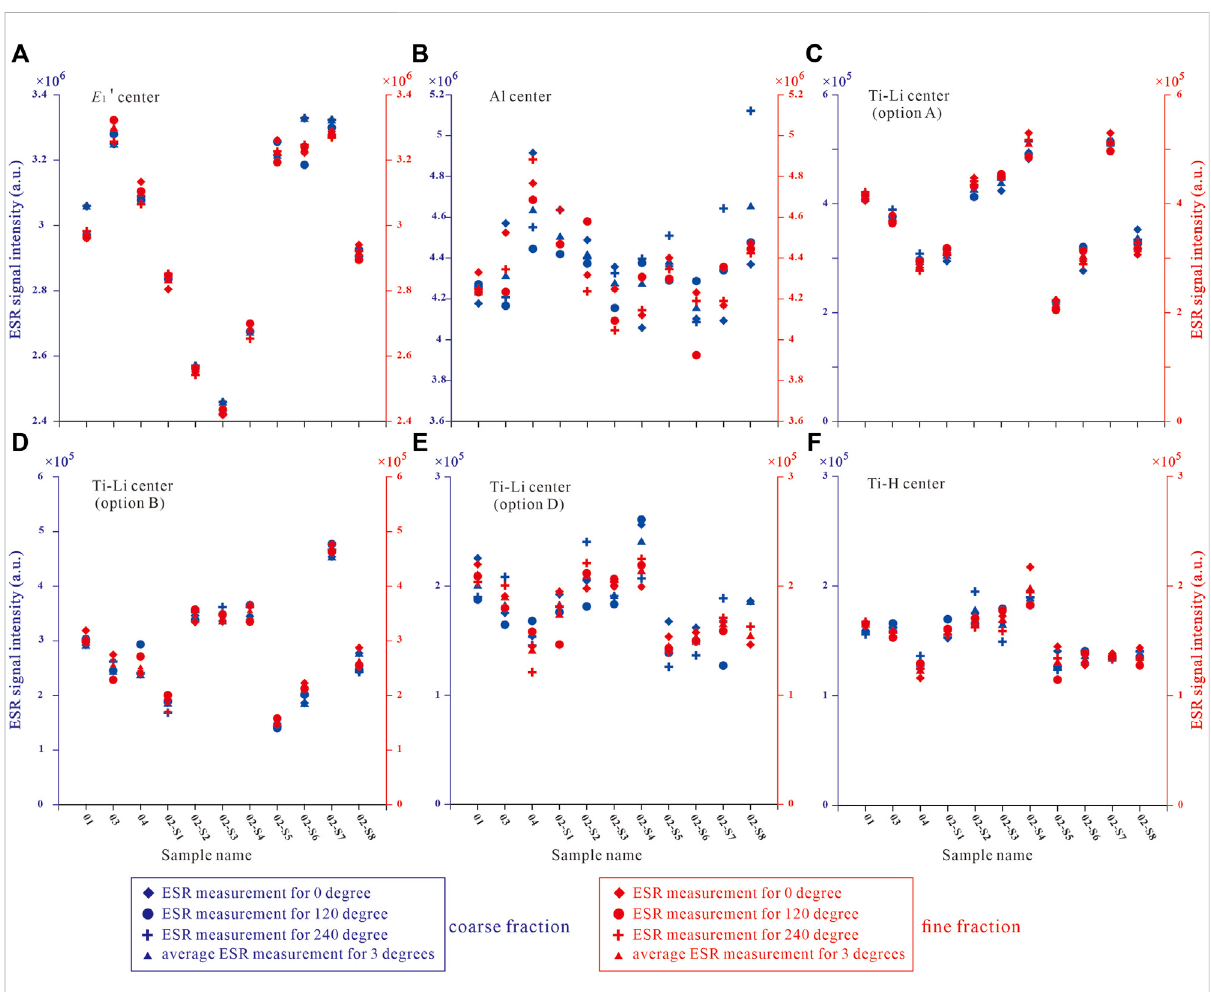
FIGURE 8 Residual signal intensities of multiple ESR centers incoarse and fi nefractions ofquartz in diluvia of theBaige dammed lake. The coarse and fi ne quartzresidualsignalintensitiesofE1 ’ centerfor (A) ,Alcenterfor (B) ,Ti-Licenter(optionA)for (C) ,Ti-Licenter(optionA)for (D) ,Ti-Licenter(option A) for (E) , Ti-H center for (F)